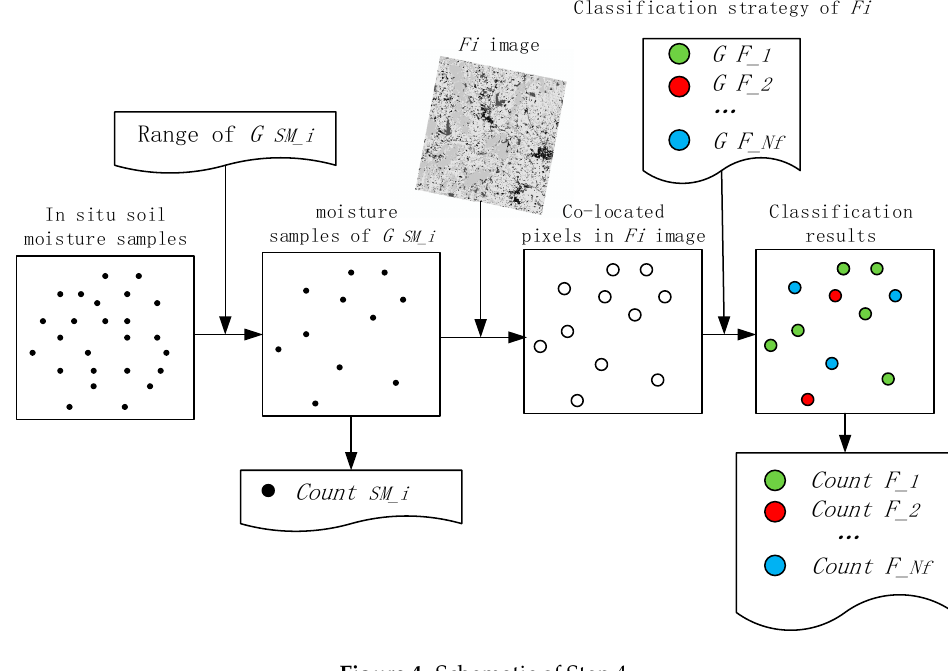
Figure 4. Schematic of Step 4.